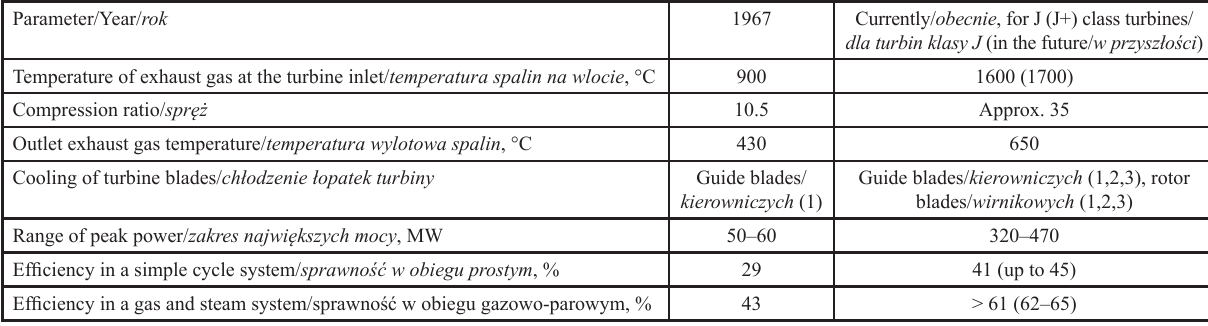
Table 1. Development of high-power gas turbines designs [4, 8] Tabela 2. Rozwój konstrukcji energetycznych turbin gazowych wielkiej mocy [4,